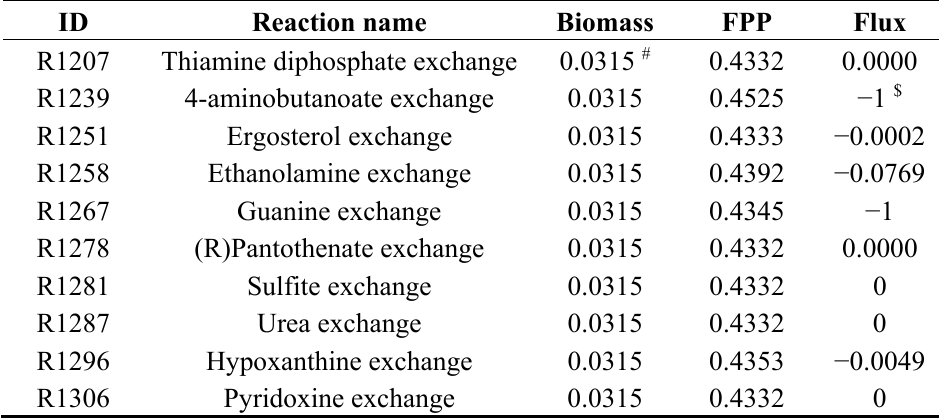
Table 3. Fluxes (mmol/g DCW/h) of 10 exchange reactions of factors used to test effects on FPP